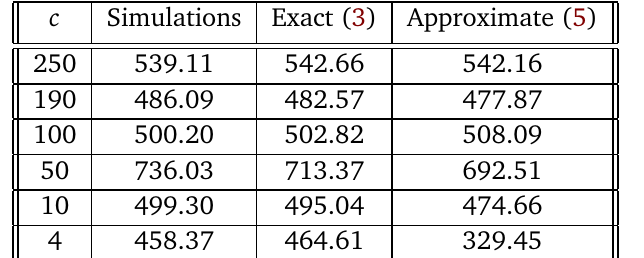
Table 1: Comparison between simulations, exact, and approximate value for the MFPT on weighted ER networks of different mean connectivity c .